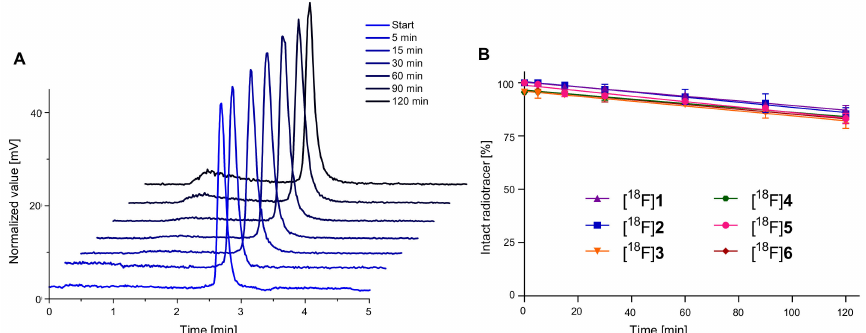
Figure 3. Depiction of the results of the in vitro serum stability evaluation experiments performed in human serum. ( A ) Radio-HPLC chromatograms for [ 18 F] 2 at certain time points and ( B ) portions of intact radiotracer over time. Values are depicted as mean ( n = 3); error bars represent SD.